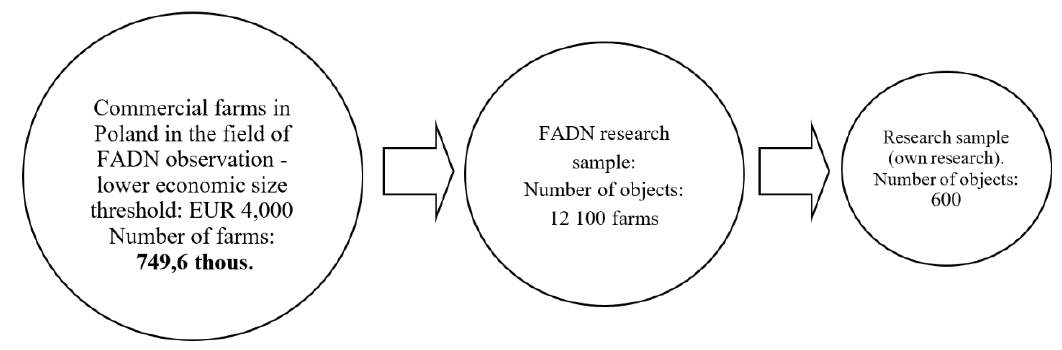
Figure 2. The general principle of the research sample construction . Source: own research.